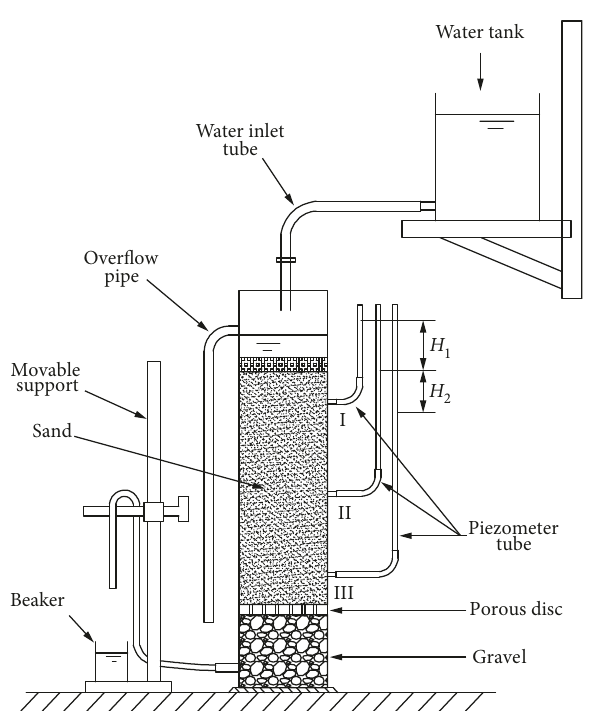
Figure 4: Testing device used in the constant head permeability test.